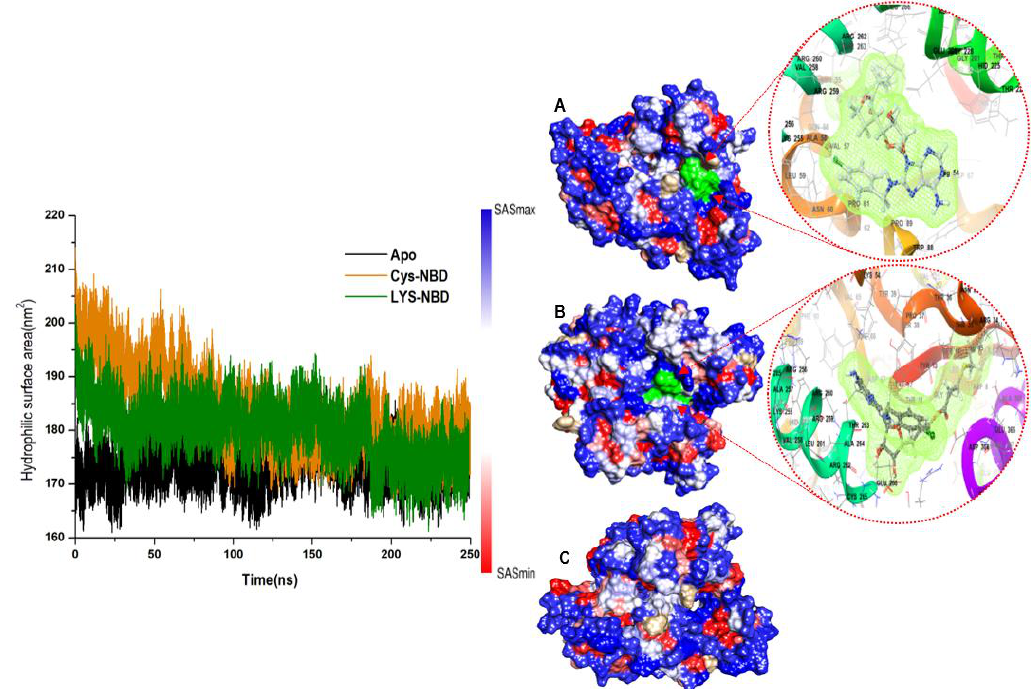
Figure 5. Solvent accessible surface area (SASA) backbone atoms relative to the starting minimized structure over 250 ns for Apo, Cys-NBD, and Lys-NBD. Areas with higher SASA values and lower SASA values are shown in blue and red, respectively, for Cys-NBD ( A ), and Lys-NBD ( B ) and Apo ( C ).